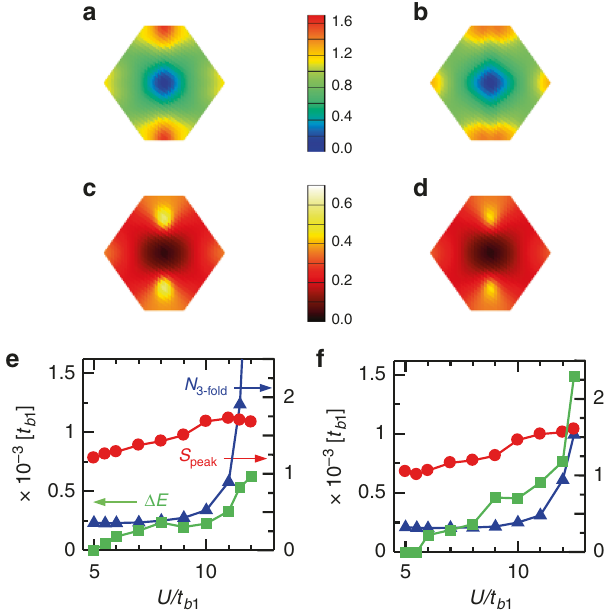
Fig. 5 Spin and charge structure factors, and superconducting condensation energies. S dim ( q ) for n hole = 0.556 ( a ) and 0.472 ( b ). N dim ( q ) for n hole = 0.556 ( c ) and 0.472 ( d ). U = t b dependence of ¼ 10 is set for all. U = t b 1 1 N S Δ E (green squares) for n 3-fold (blue triangles), peak (red circles), and hole = 0.556 ( e ) and 0.472 ( f ). The symmetry of SC is the d xy -wave (extended- s + d n = 0.556 (0.472). The statistical errors of the x 2 (cid:1) y 2 -wave) for hole Monte Carlo sampling are within the size of the symbols in e and